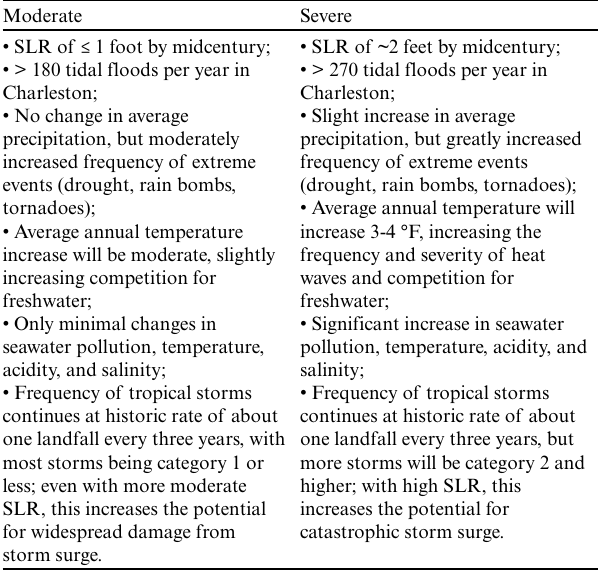
Table 2 . Characterizations of moderate and severe climate change used to develop alternative future scenarios for the Lowcountry of South Carolina. Note: SLR = sea-level